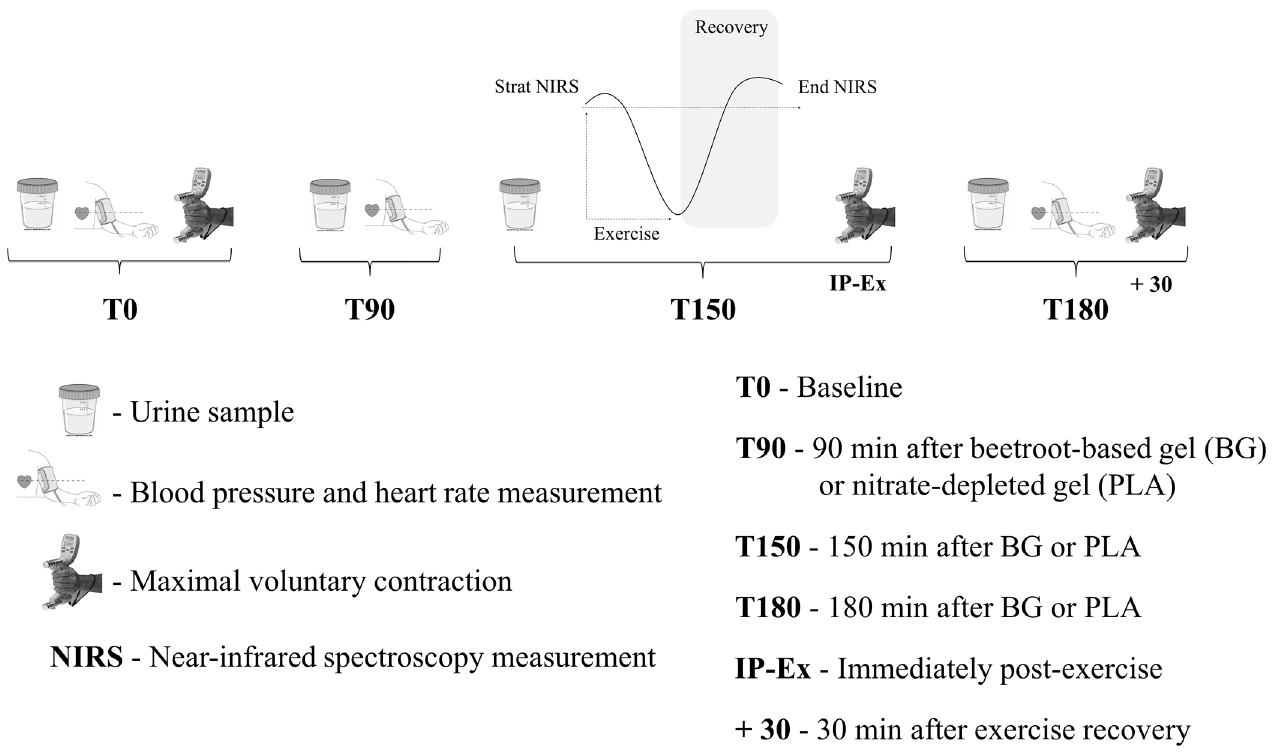
Fig 2. Experimental design of the